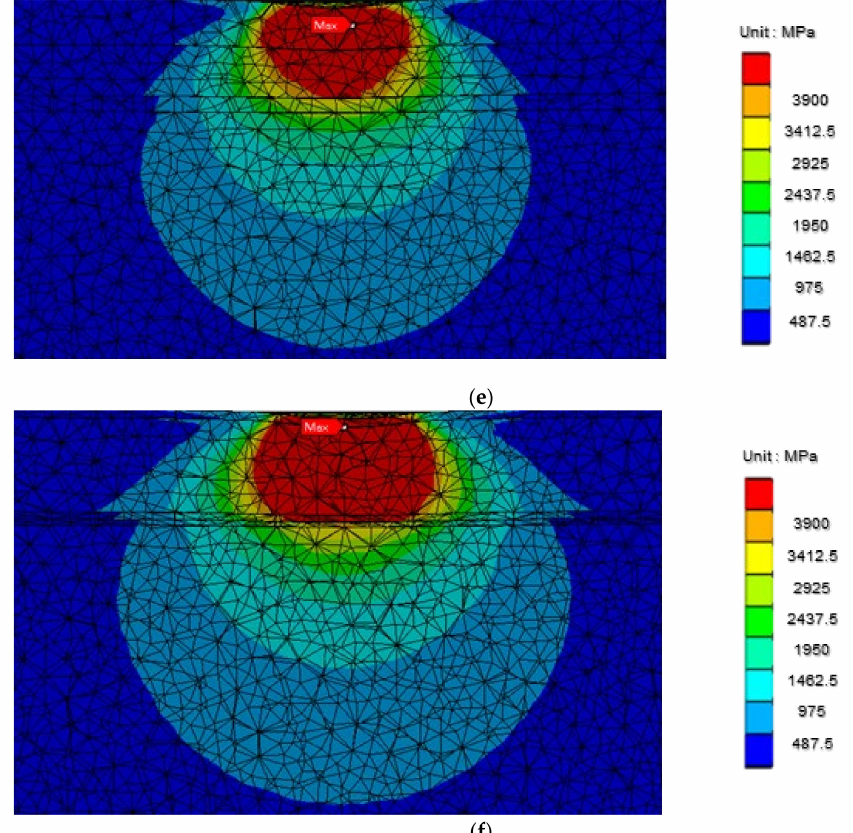
Figure 14. Von-Mises stress distributions of ( a ) Ti-6Al-4V, ( b ) TiNbZr, ( c ) TiNbZrTa, ( d ) TiNbZrTa(N), ( e ) TiNbZrTa-O, and ( f ) TiNbZrTa(N)-O